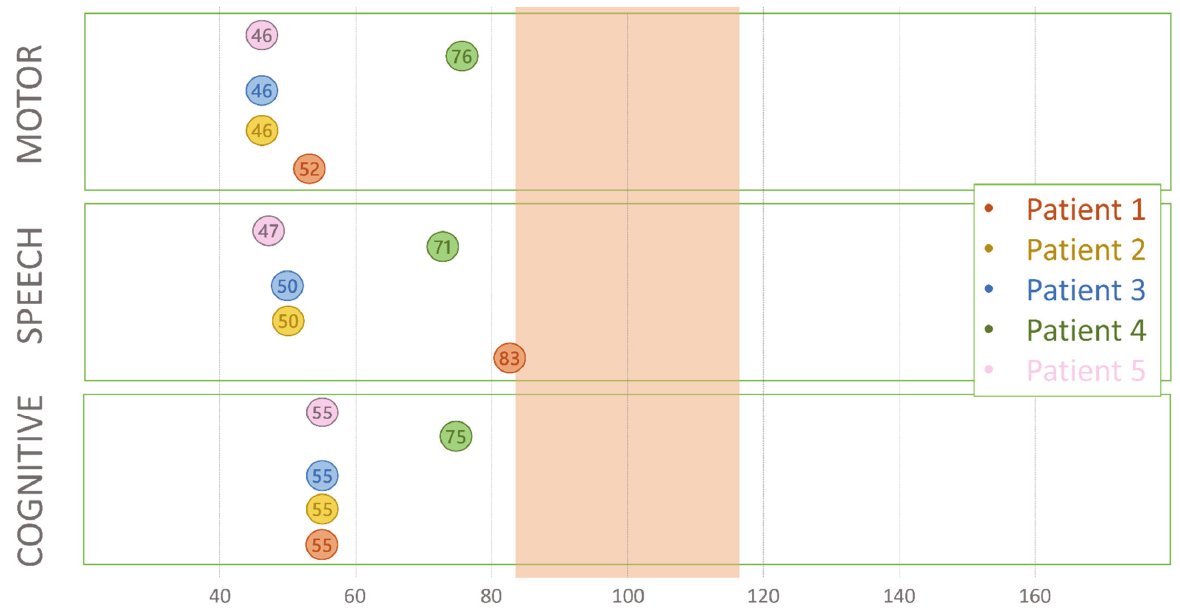
Figure 1. The Bayley Scales of Infant and Toddler Development Third Edition (Bayley-III). The image shows the performance of each patient (identified by a different color) in the three subscales. The standardized mean score is 100 ± 15 standard deviation (highlighted area), values lower than 85 indicate mild impairment, and lower than 70 indicate moderate or severe impairment.